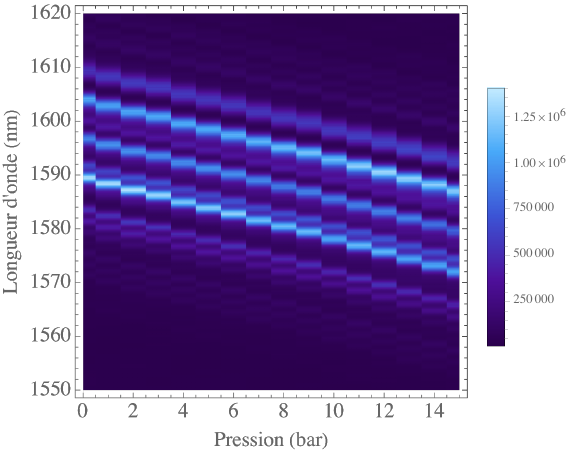
Fig. 1. Plot of the nanofiber emission spectra as a function of Argon pressure for a pump beam at